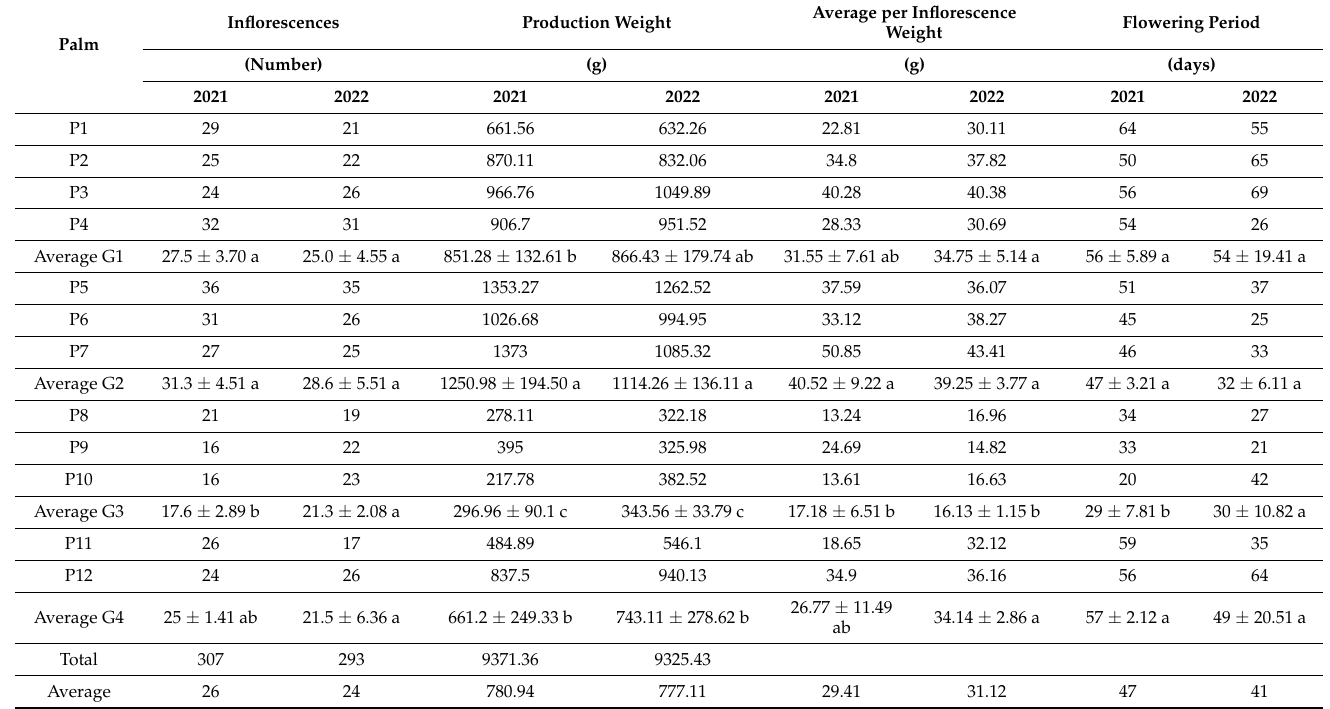
Table 3. Number of inflorescences, pollen production, average per inflorescence, and flowering period of the twelve seedling date palm males, selected for pollen